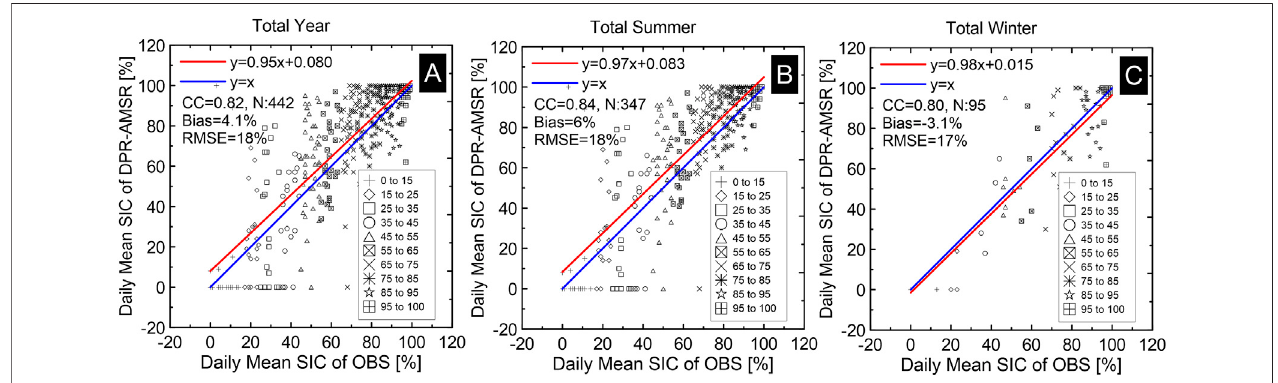
FIGURE 11 | Scatterplots of co-located daily average sea ice concentration from ship-based visual observations (OBS) and from DPR-AMSR. Data from 2002 to 2011 were used for (A) years, (B) summers, and (C) winters. Blue solid lines represent the equation y = x . Red solid lines represent linear fi ts of data points. Linear equations,correlationcoef fi cients(CC),numberofvaliddatapairs(N),andbiasesandrootmeansquareerrors(RMSE)arealsopresented.SummerincludesMay,June, July, August, and September; winter includes the other